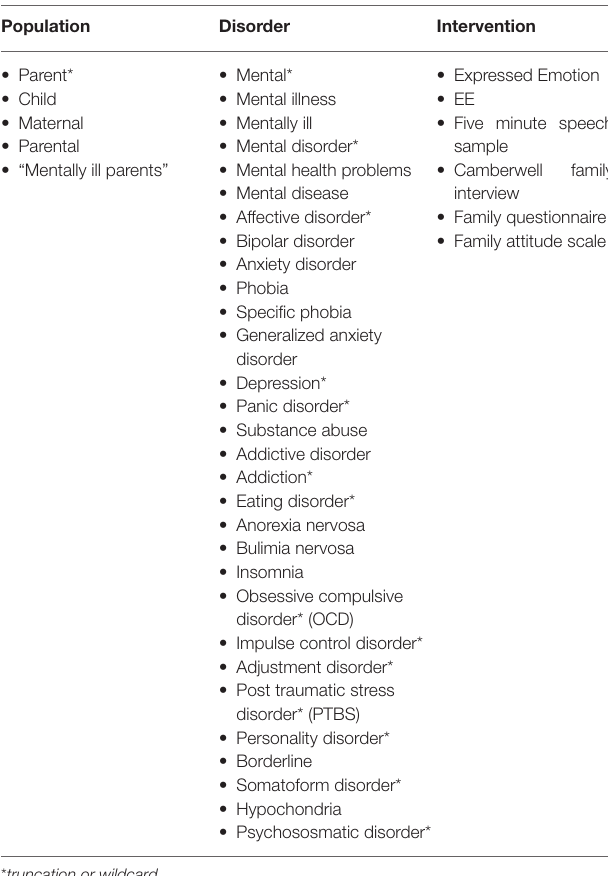
Table A1 | Full search strategy for databases; terms within categories were combined with OR, between categories with AND.